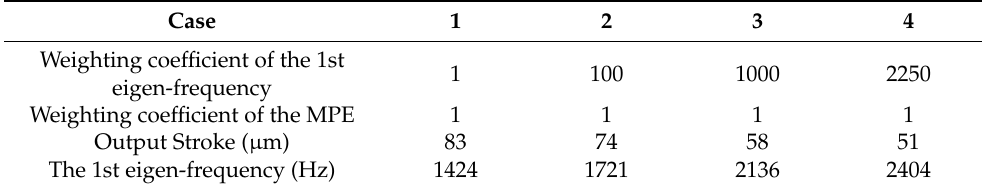
Table 3. Four types of optimized result with different weighting coefficient of the 1st eigen-frequency.